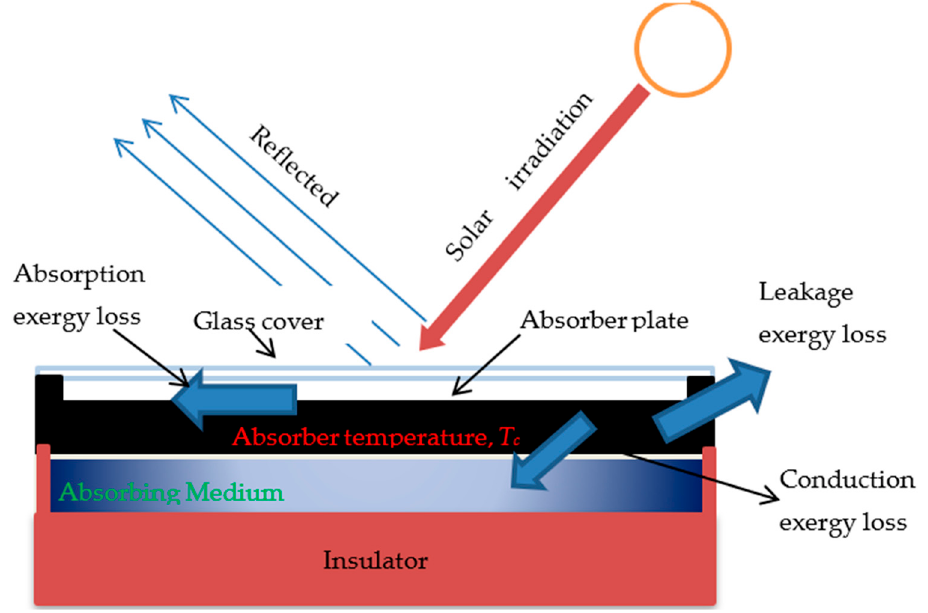
Figure 1. A schematic diagram for different exergy losses.